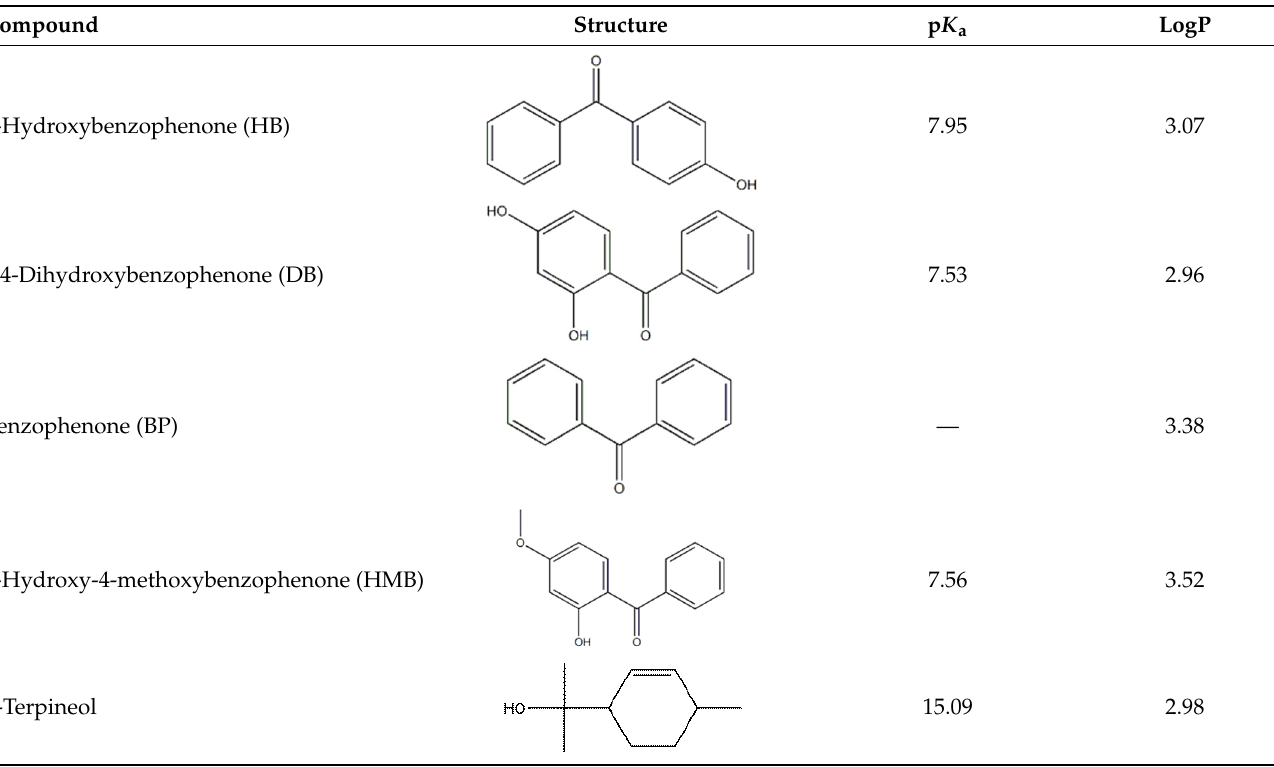
Table 1. Structure and physicochemical properties of benzophenone compounds and extractants in this study.